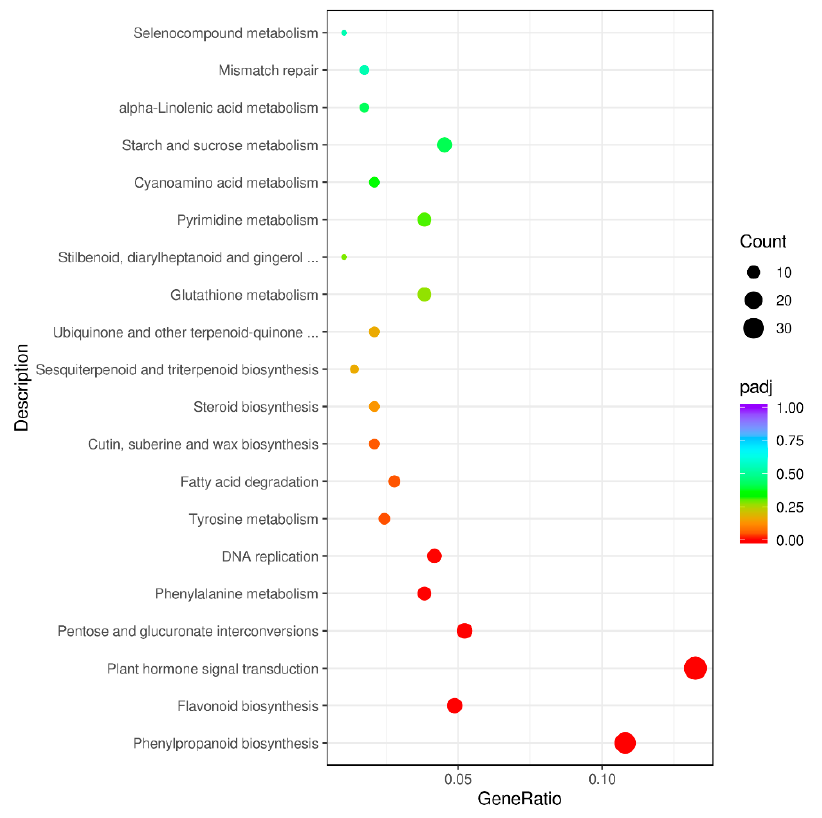
Figure 5. KEGG pathway analysis of the DEGs between purple non-heading Chinese cabbage and its green mutant.